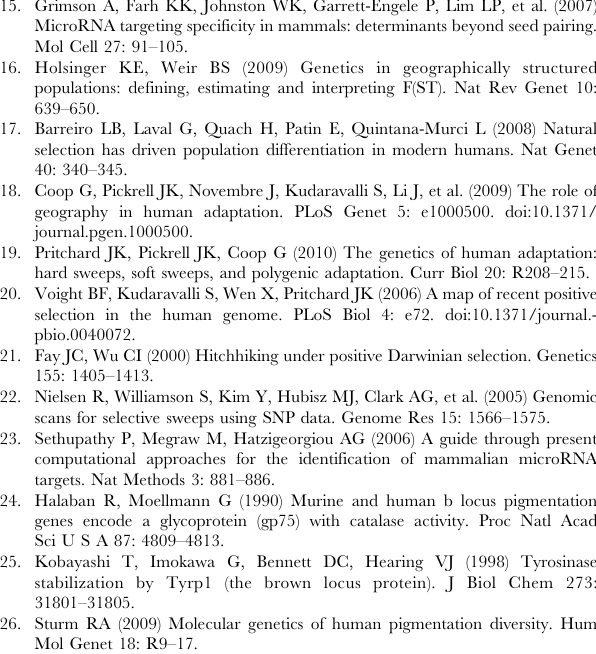
Figure S7 Plots of the extended haplotype homozygosity (EHH) in the 0.5 Mb region centering at rs683 in CEU (A), East Asia (B) and YRI (C). Haplotypes carrying the ancestral or the derived allele of rs683 are in blue or red, respectively. Figure S8 Histograms of the Pearson’s correlation coefficients between the absoulte latitides of HGDP populations and the derived frequencies of SNPs across the genome (A) or SNPs with high- F ST ( $ 0.5) (B). In either case the correlation derived by rs683 is among the extreme 1% of all the SNPs analyzed (the red bar). Figure S9 Evaluation of the cross-hybridization between probes for the TaqMan SNP qPCR assay for rs683. In this assay one probe conjugated with VIC fluorescence dye monitors the ancestral allele (the blue circles) and the other probe conjugated with FAM fluorescence dye detects the derived allele (the red squares). Constructs A and B used in Fig. 2B were used for this evaluation, carrying the ancestral and derived alleles, respectively. 8 samples with the mixed construct A and B were prepared as the following ratio of A to B: 1:0, 1:1, 1:2, 1:4, 4:1, 2:1, 0:1, with the constant total DNA concentrations for the 8 samples at 0.1 ug/ul. Expected Relative Fraction refers the fraction of the construct in the mixed samples relative to the construct in the sample without mixing the other construct. Observed Relative Fraction was obtained using qPCR D Ct of the construct in the mixed sample relative to the D Ct of the construct in the sample without mixing the other construct. Using data points for Observed (x-axis) and Expected (y-axis) Relative Fractions, two regression lines were plotted for the FAM (the red line for the derived allele) and VIC (the blue line for the ancestral allele) signals respectively. The slopes of the blue and red lines are 0.91 and 0.94, respectively, very close to 1. R square values for both regression lines are 0.95 and 0.92 respectively, indicating a lack of cross-hybridization between probes for the alternate alleles of rs683.